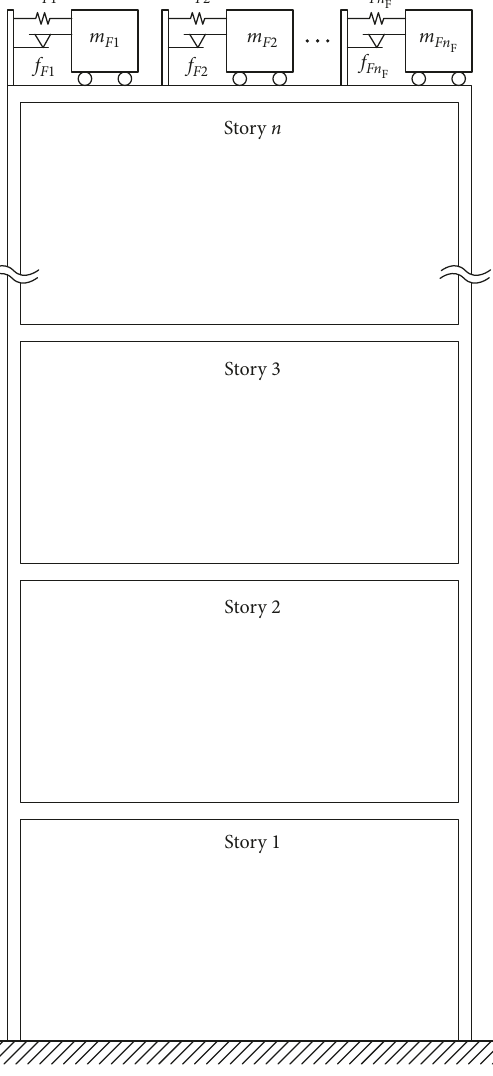
Figure 3: n -story structure equipped with n